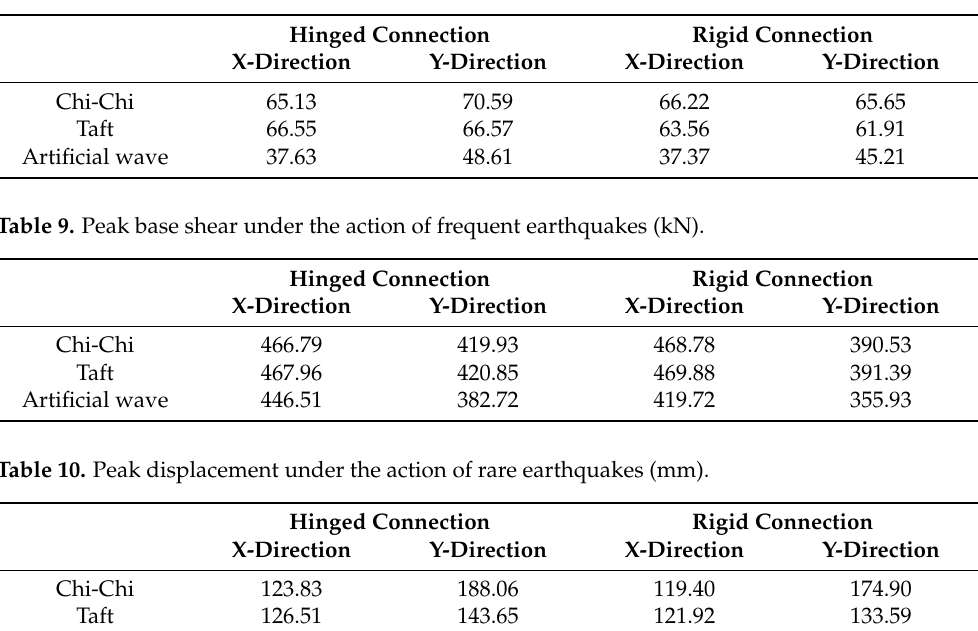
Table 8. Peak acceleration under the action of frequent earthquakes (cm/s 2 ).